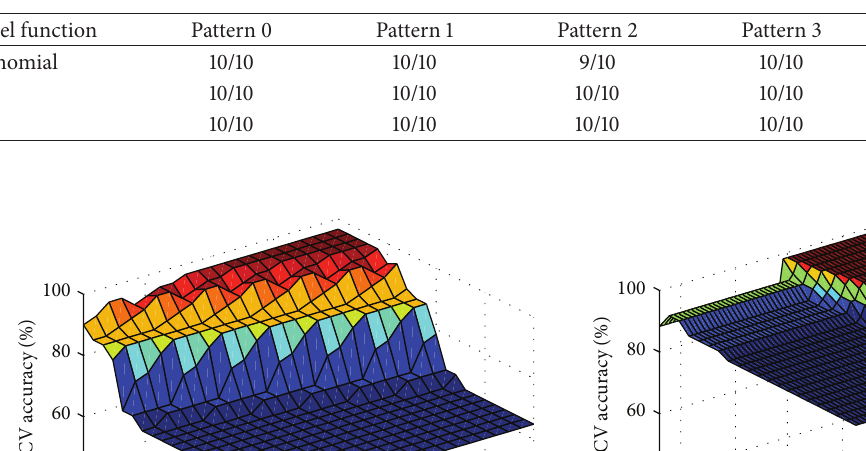
Table 5: The classification result of the testing samples.